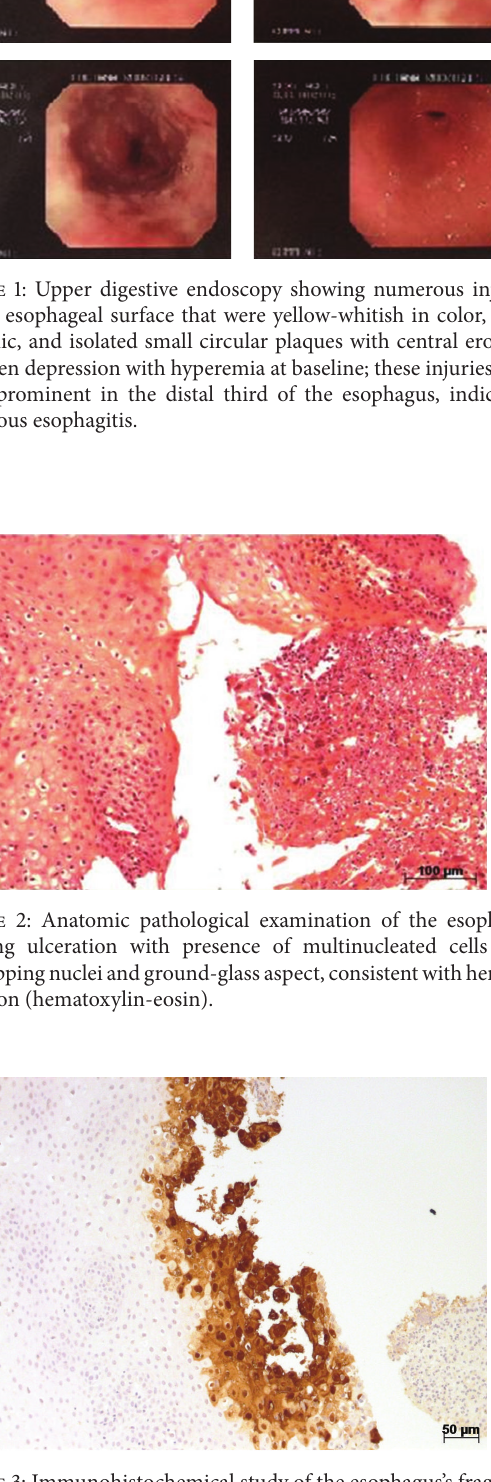
Figure 3: Immunohistochemical study of the esophagus’s fragment showing positivity to herpes simplex virus type